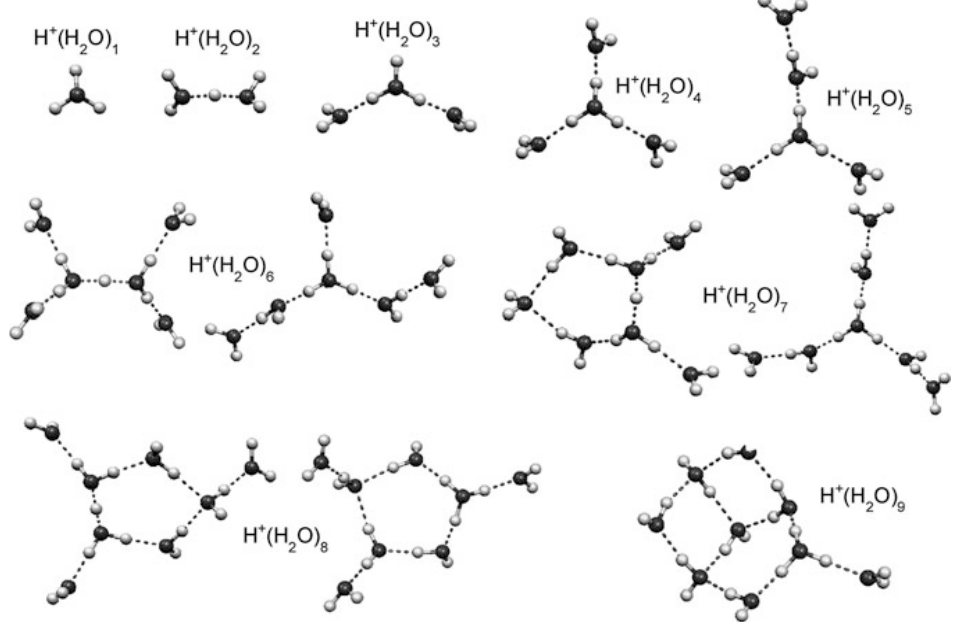
Figure 21. Experimentally characterized structures of H + (H 2 O) n . Figure adapted from [15] with permission. Copyright 2011 The Royal Society of Chemistry.